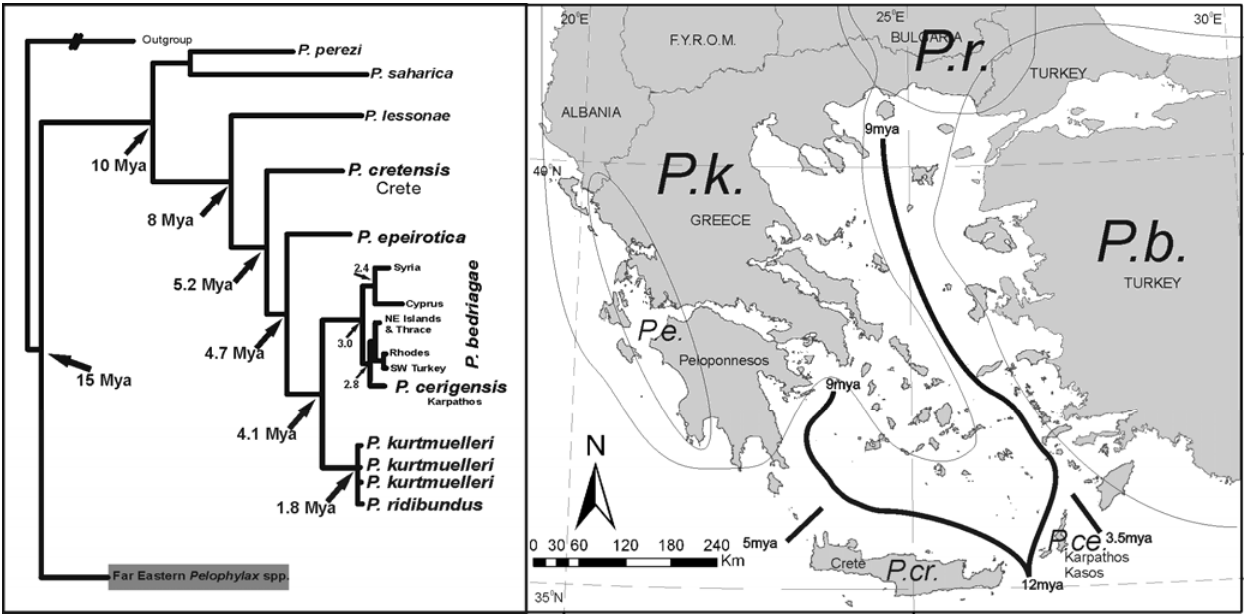
Figure 7. Phylogenetic relationships and distribution of Pelophylax spp. in the area after [21]. Despite the complex relationships, taxa still respect the 12-9 MYA